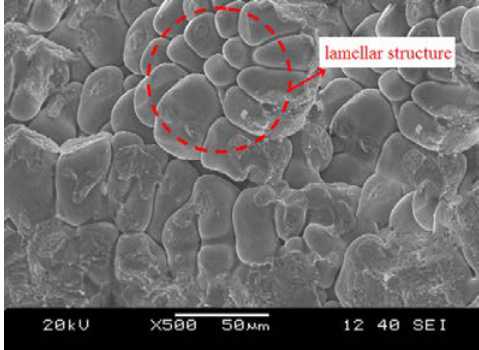
Figure 9. Enlarged view of area B in Figure 6.